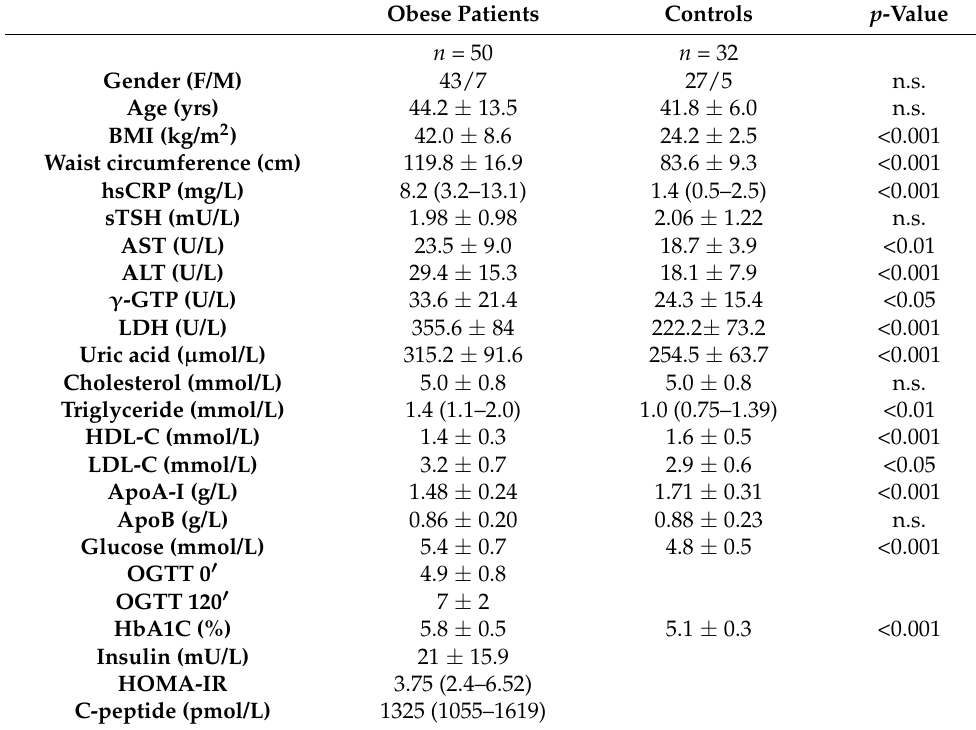
Table 1. Characteristics and laboratory parameters in obese patients and